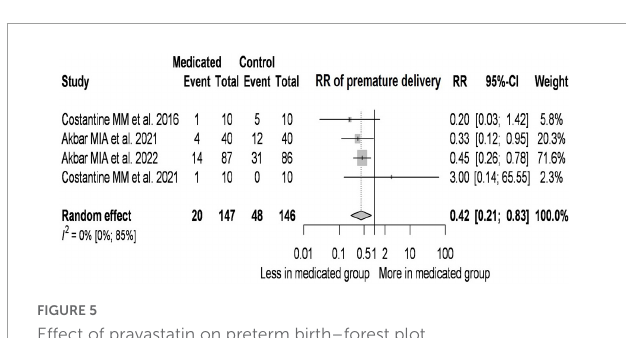
FIGURE5 Effect of pravastatin on preterm birth–forest plot.